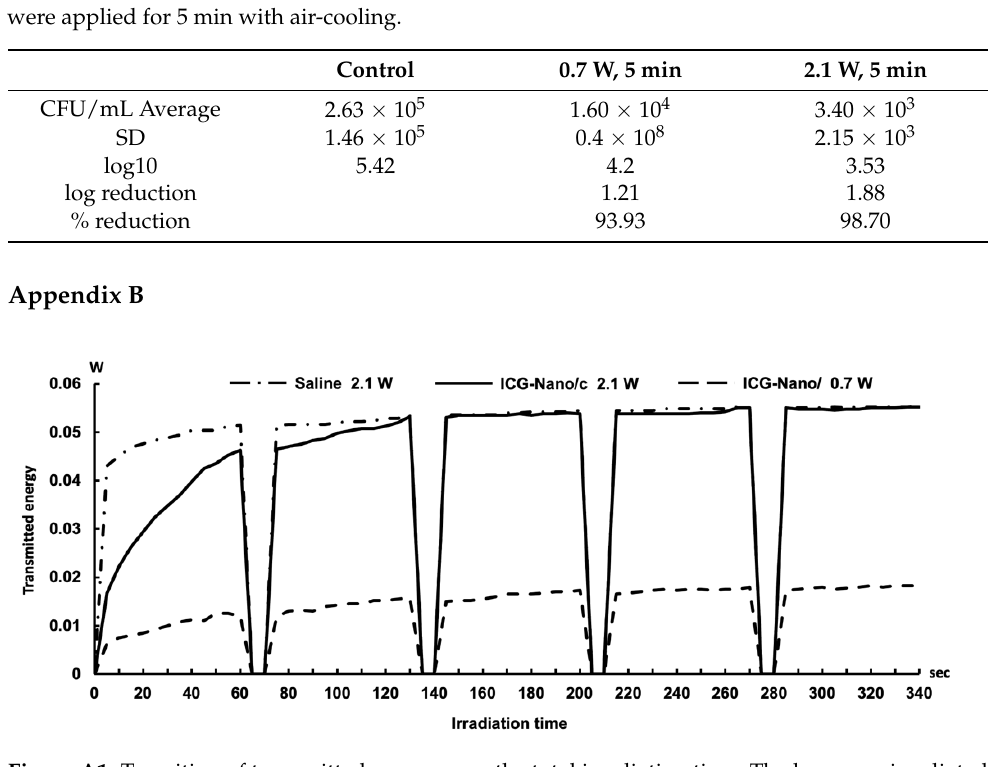
Figure A1. Transition of transmitted energy over the total irradiation time. The laser was irradiated on the tooth root intermittently for 5 min with a rest period of 10 s every minute. Canals of the root were filled with ICG-Nano/c, saline or none. The light energy transmitted through the tooth root was measured during full time irradiation and recorded every 5 sec.